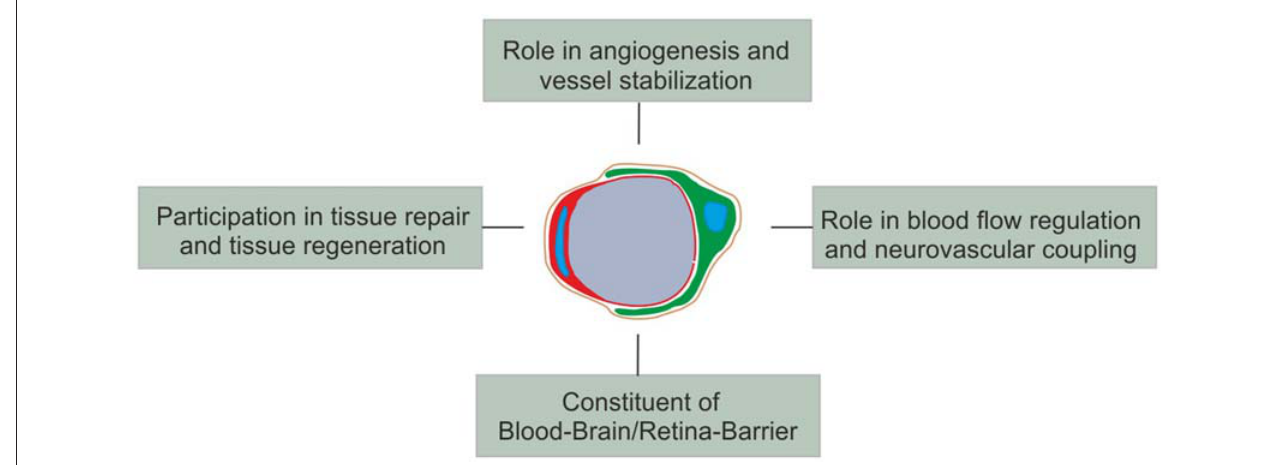
FIGURE 3 | Schematic overview of (the main) pericyte functions